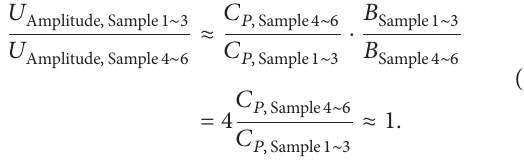
the output voltages of different samples accurately, indirectly proving that the basic model is accurate.